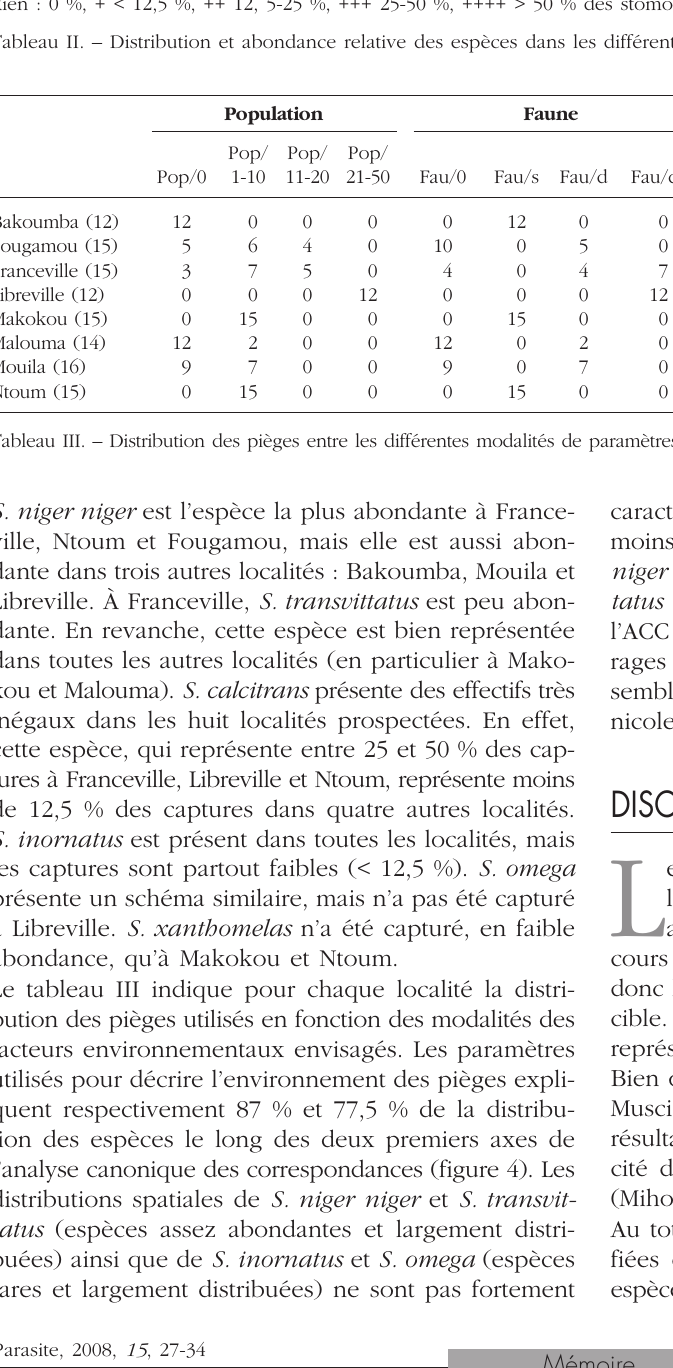
Tableau II. – Distribution et abondance relative des espèces dans les différentes localités.